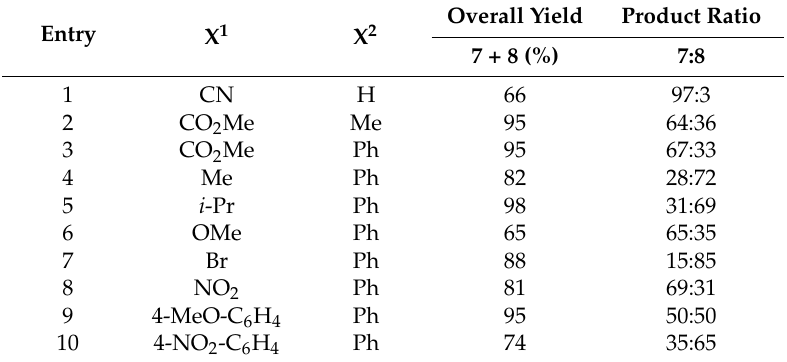
Table 3. Cycloaddition between diphenylnitrilimine 6 and mono- or disubstituted ethenes giving regioisomeric pyrazolines 7 and 8 (RG-III).